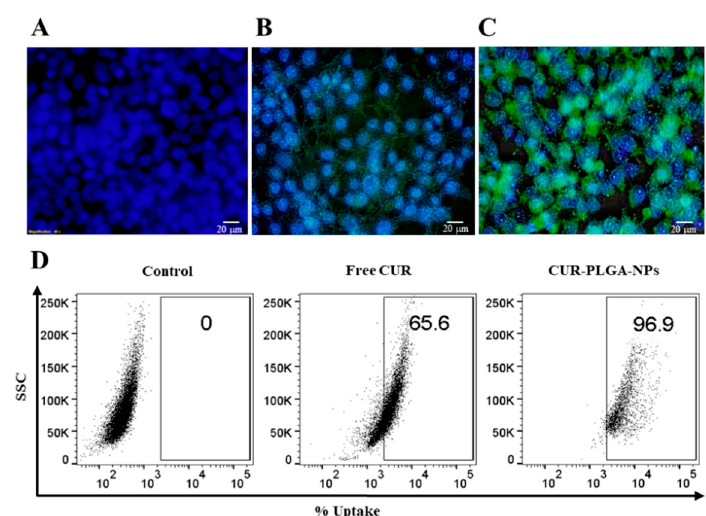
Figure 10. Cellular uptake studies in FaDu cells showing qualitative analysis of cellular localization ( A ) control (no treatment); ( B ) free CUR; ( C ) optimized CUR-PLGA-NPs (magnification 40 × ); and ( D ) quantitative analysis of cellular uptake by flow cytometry.